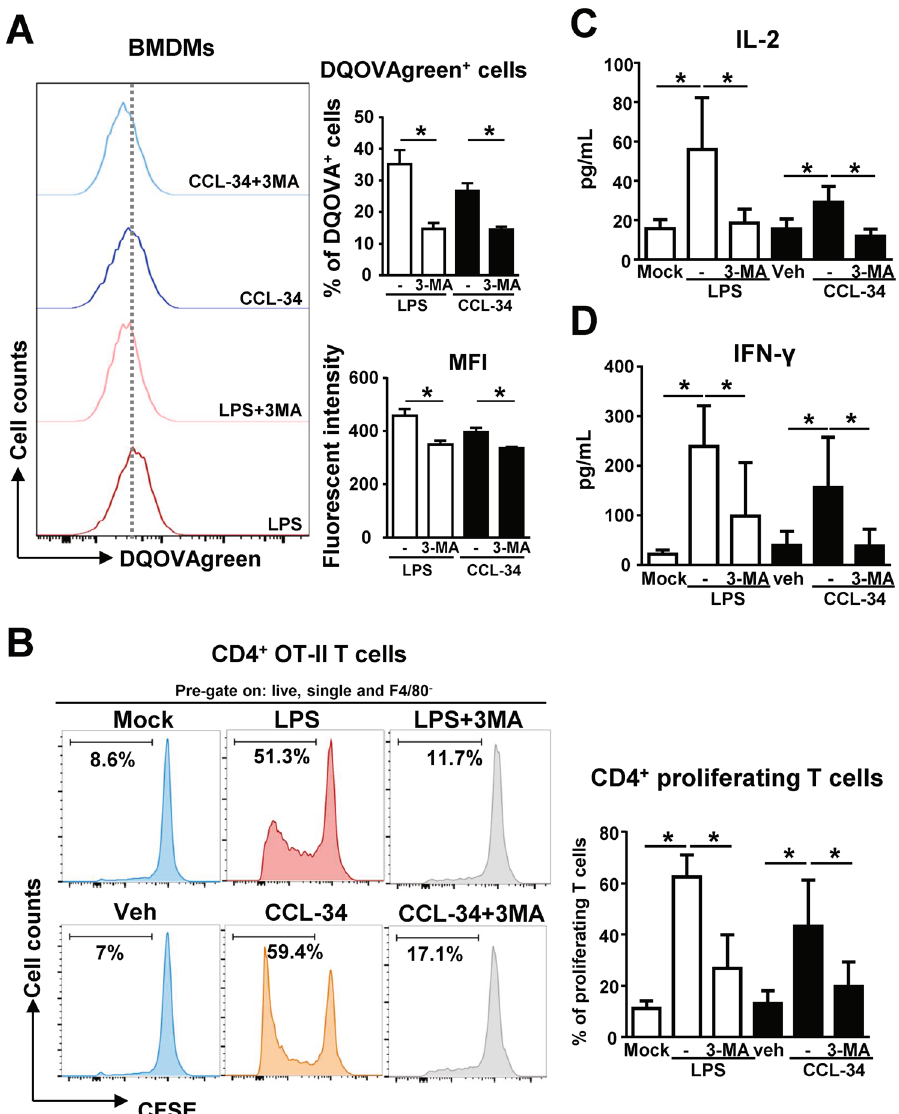
Figure 4. Autophagy is involved in the Ag-specific T cell responses induced by CCL-34-stimulated BMDMs. (A) The Ag processing activity of CCL-34-stimulate macrophage is suppressed by autophagy inhibitor 3-MA. BMDMs generated from C57BL/6 were treated with 3-MA (5 mM) for 1 hour and then incubated with LPS (100 ng/mL), vehicle (0.1% DMSO), or CCL-34 (30 μ M) for 24 hours in the presence of 5 μ g DQ-OVA (2.5 µ g/ mL) for 24 hours. (Left panel) Representative histogram showing flowcytometric analysis of DQ-OVA + BMDMs; (right panel) the quantitative data (n = 3). (B) The CD4 + T cell proliferation stimulated by CCL- 34-stimulate macrophage is blocked by 3-MA. BMDMs generated from C57BL/6 were stimulated with the candidate drugs in the combination with 5 μ M OVA-peptide 323–339. The stimulated BMDMs and CFSE- labeled OT-II CD4 + T cells were cocultured for 5 days. A representative histogram and the quantitative data of multiple experiments are shown (n = 5). (C,D) The production of IL-2 and IFN- γ induced by co-culture of CCL-34 with CD4 + T cells is suppressed by 3-MA. The production of IL-2 (n = 6) (C) and IFN- γ (n = 7) (D) was measured using ELISA. The results were plotted using GraphPad Prism version 8.1.0 (www.graphpad. com). All the data are shown as the mean ± SD, and * p < 0.05 indicates significant difference versus the medium control or vehicle control analyzed using Student’s t-test. The gating strategies are presented in Supplementary Fig.